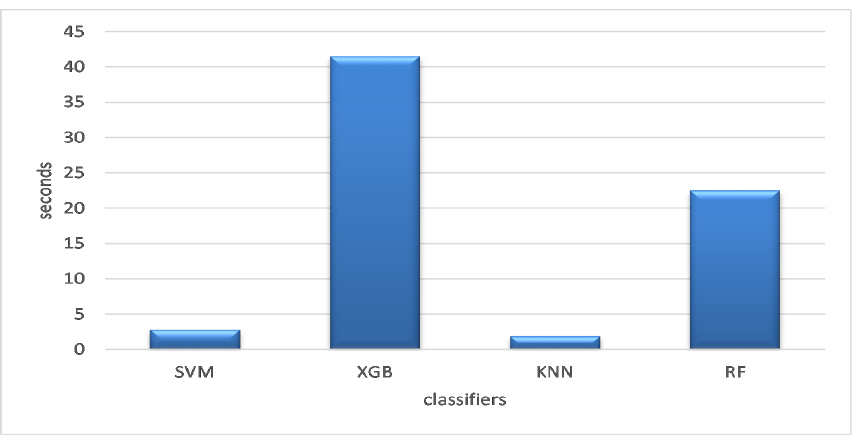
Figure 6. Average execution time of the classifiers across the